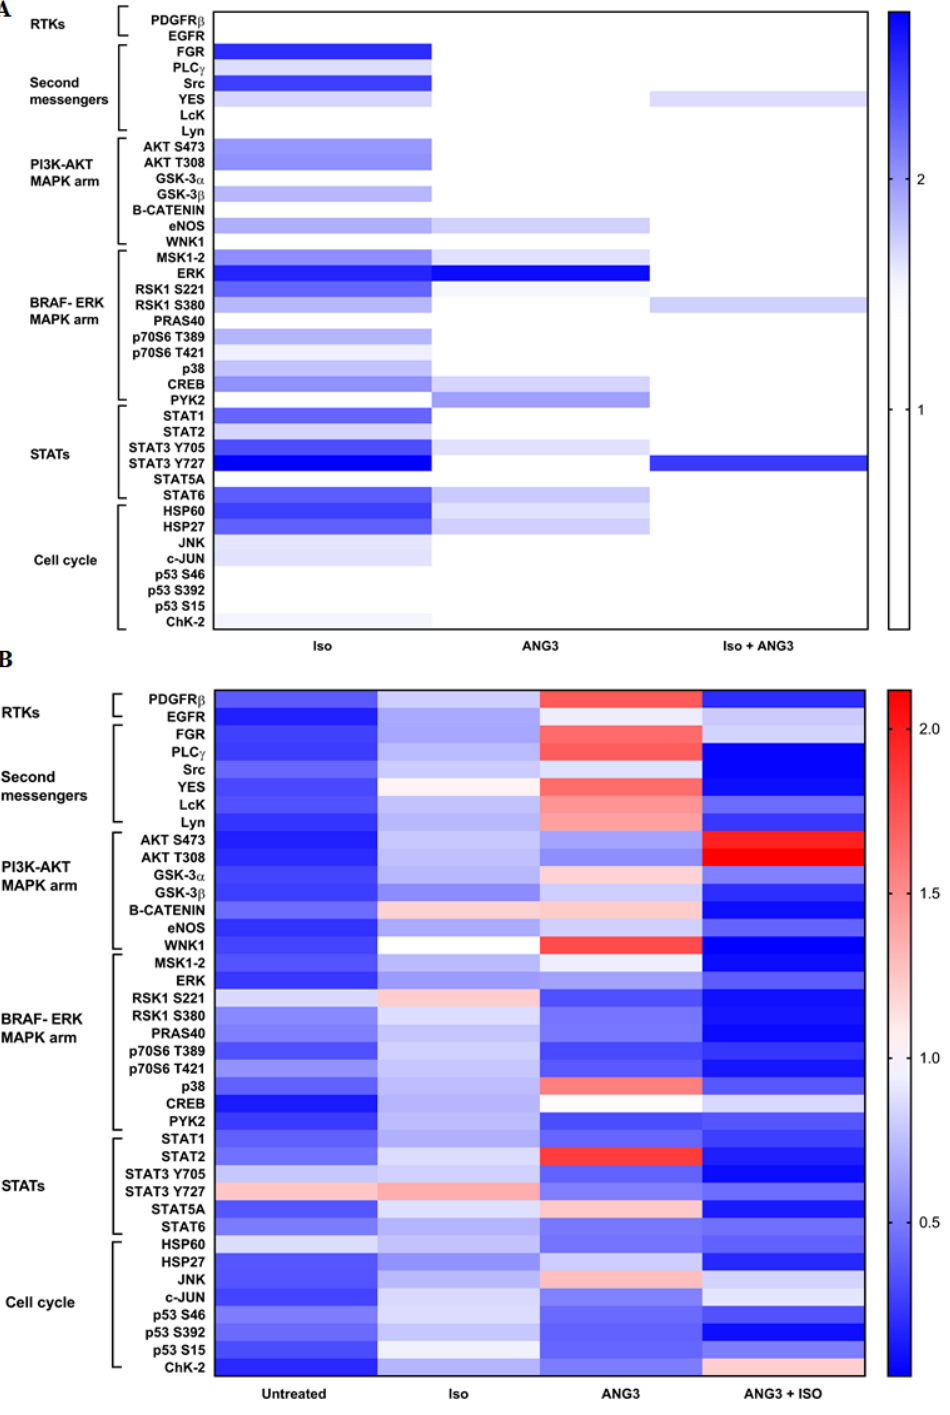
Figure 4. Proteome profiling heatmap—The Y-axis reports the name of the 39 studied proteins in the proteome profiler assay, and the X-axis reports experimental conditions. Panel A , the phosphor- ylation levels are normalized to the untreated sample and expressed as fold-change. Increased levels of phosphorylation are indicated by darker tones of blue, and the decreased levels are in white. Panel B , phosphorylation levels after 48 h of vemurafenib inhibition; data are expressed as fold- change and normalized for the sample without inhibition. Increased levels of phosphorylation are indicated by darker tones of red, and the decreased levels are indicated by darker tones of red.